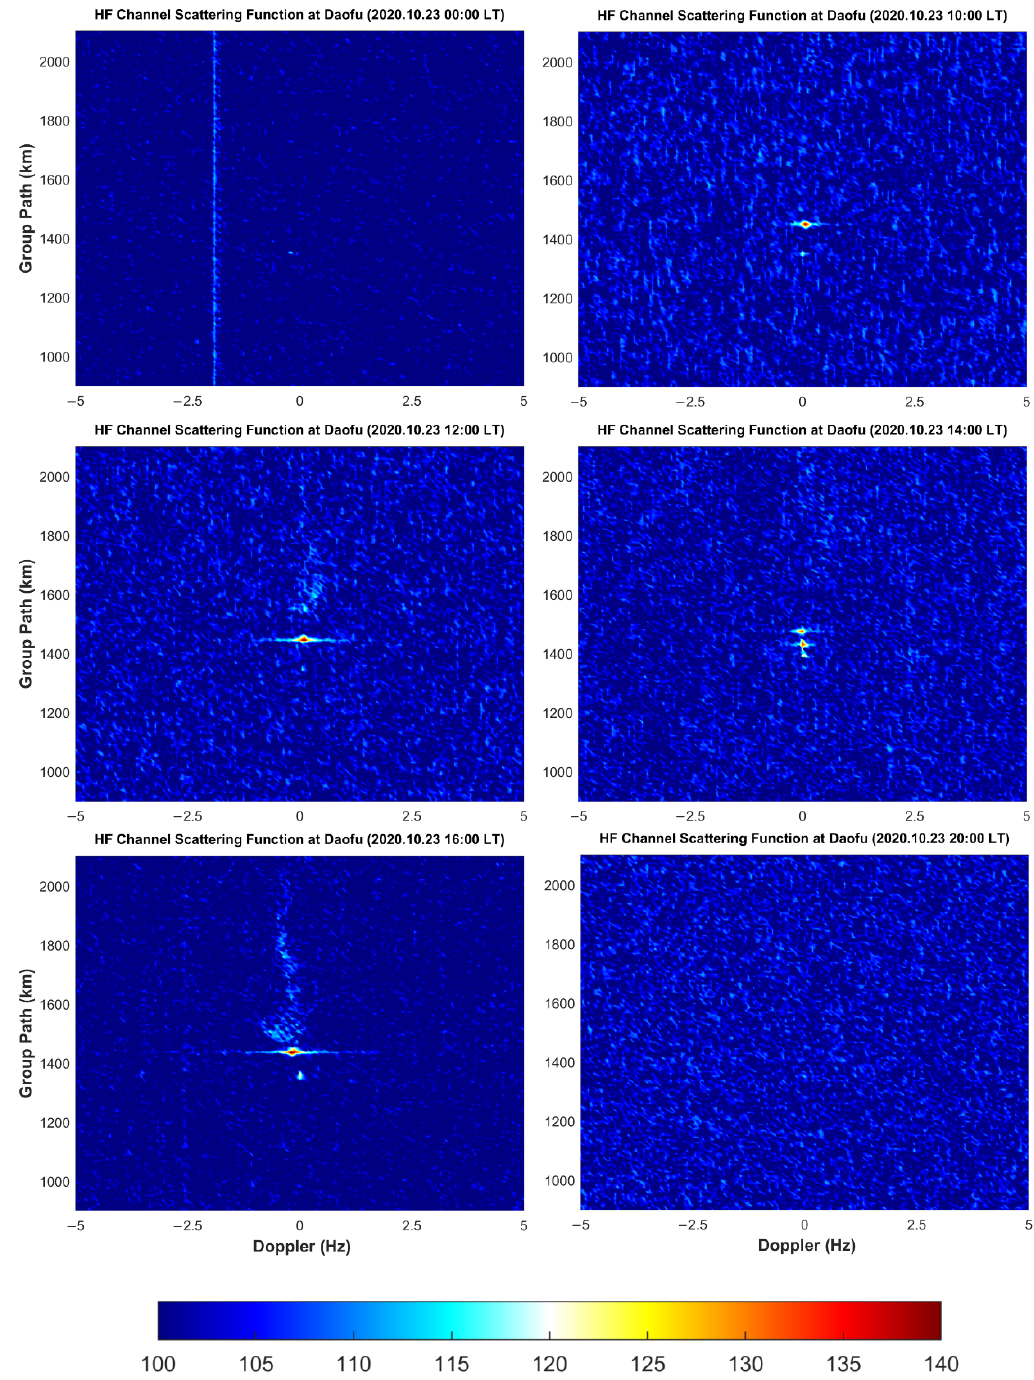
Figure 7. 23 October 2020, data processing results of Daofu station. Refer to the captions in Figure 2 for the receiving time and other descriptions of each panel.